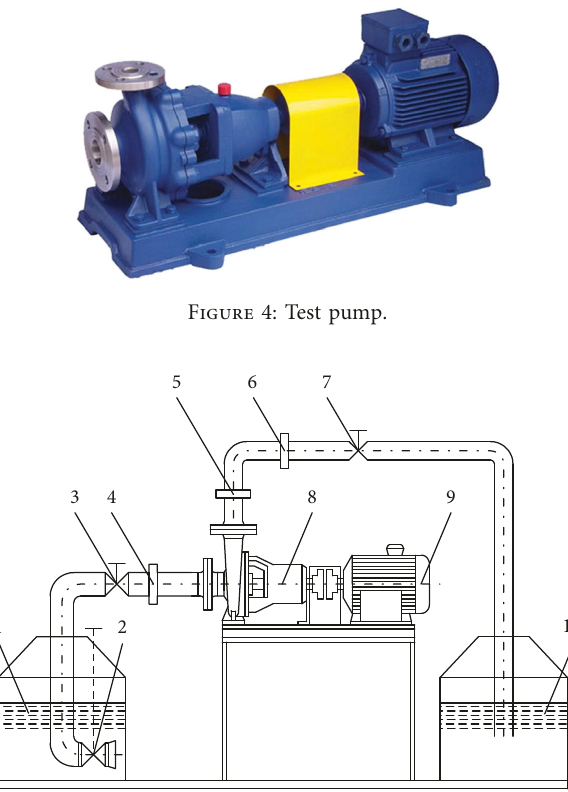
Figure 5: External characteristics test bench. (1) Water tank. (2) Vacuum control valve. (3) Inlet control valve. (4) Vacuum table. (5) Pressure gauge. (6) Flow meter. (7) Flow control valve. (8) Test pump. (9) Motor. (10) Water